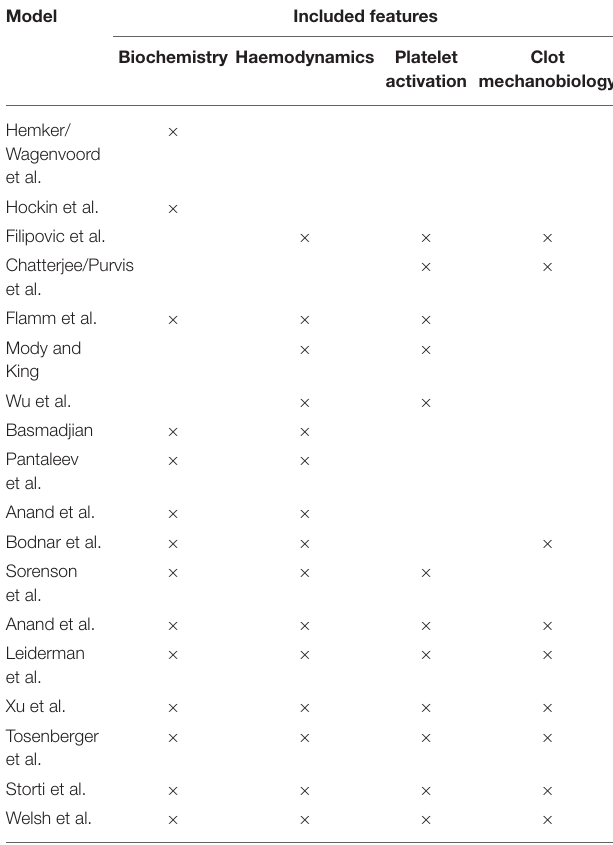
TABLE 3 | Summary of the physiological clotting models, illustrating the aspects of coagulation that each model